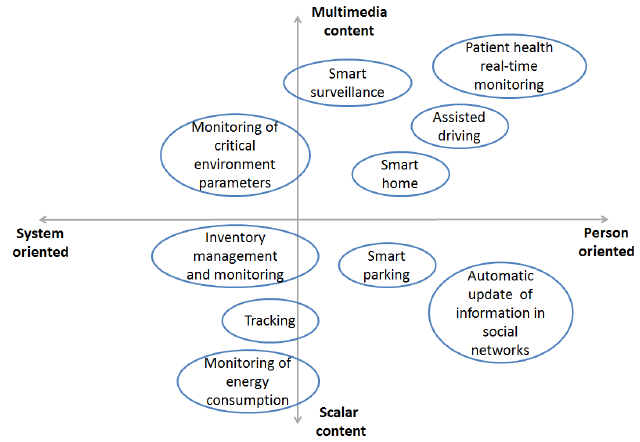
Figure 2. Classification of IoT applications on the basis of the type of information they manage (multimedia or scalar content) and of the type of recipient (person or system